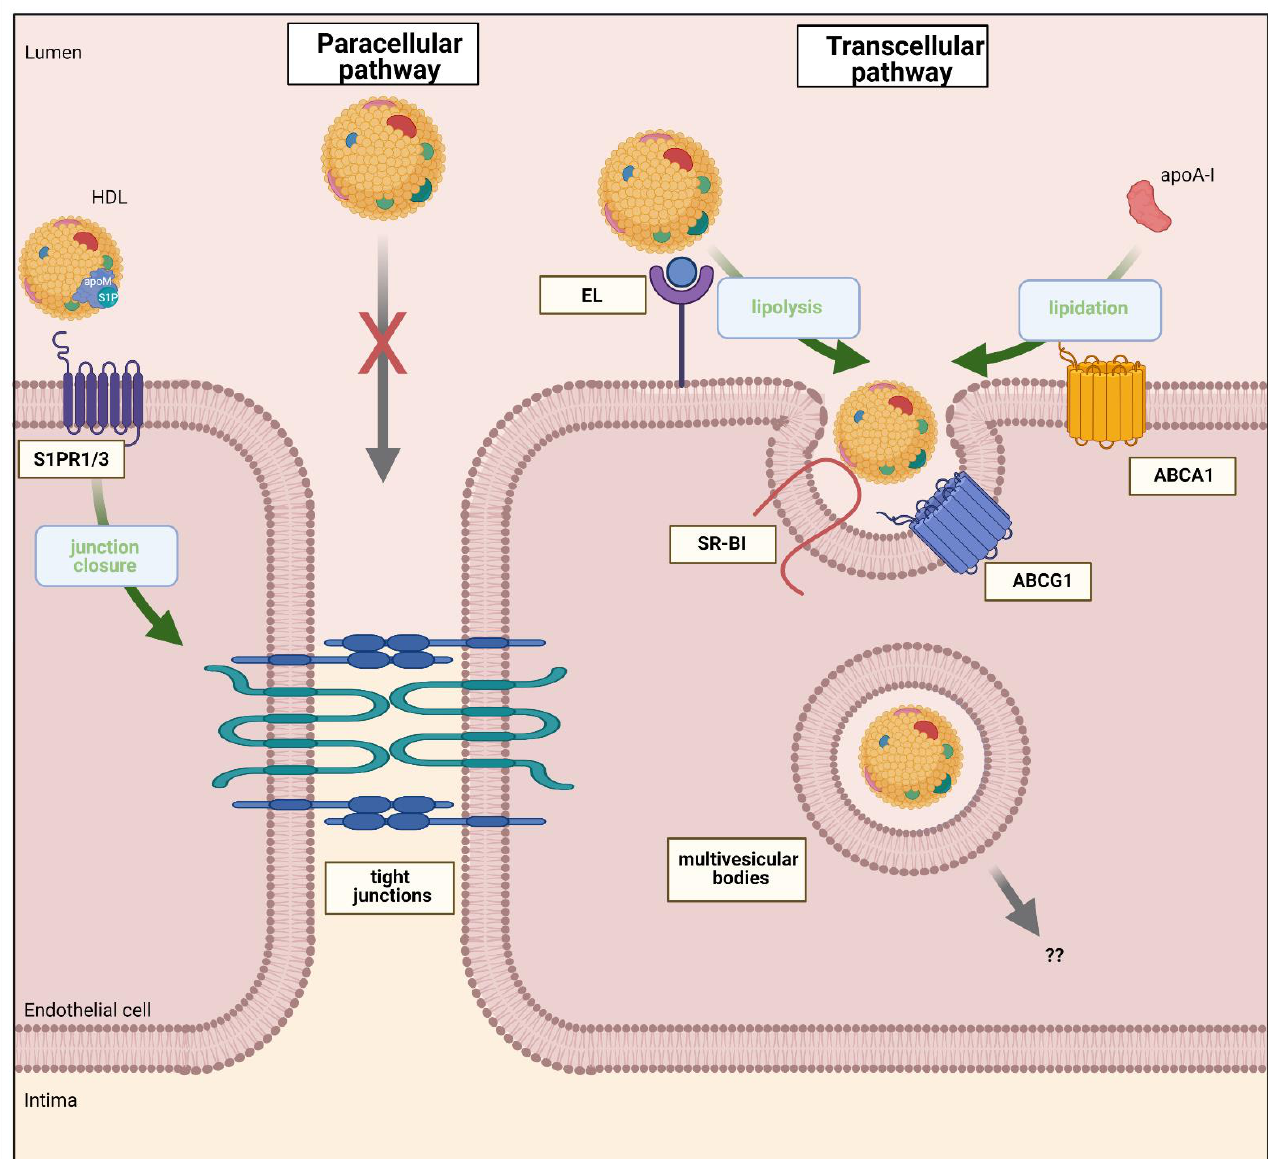
Figure 2. Transendothelial transport of HDL. S1P bound to HDL induces endothelial cells junction closure preventing paracellular pathways. HDL binds to EL that lipolyses it to generate HDL particles with smaller stoke diameter. Resulting HDL binds to SR-BI and ABCG1 and is internalized. Lipid-free apoA-I is lipidated by ABCA1 before being transported like HDL. Internalized HDL is trafficked via endosome and multivesicular bodies before being exocytosed via an unknown pathway.